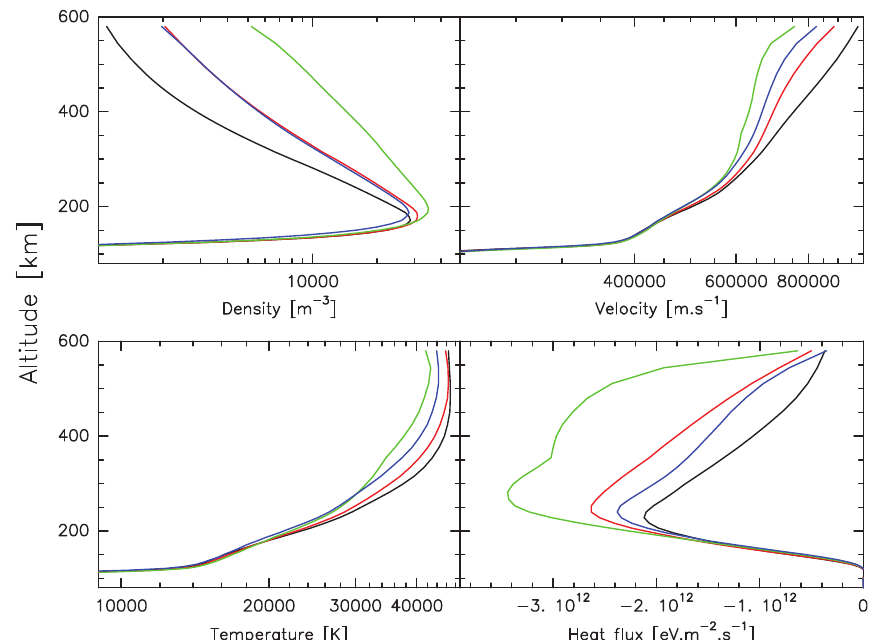
Fig. 7. Suprathermal moments for the four cases under study. As in Figure 6, the color code is: F 10.7 = 80, Ap = 3 (black), F 10.7 = 120, Ap = 3 (red), F 10.7 = 200, Ap = 3 (green) and F 10.7 = 80, Ap = 300